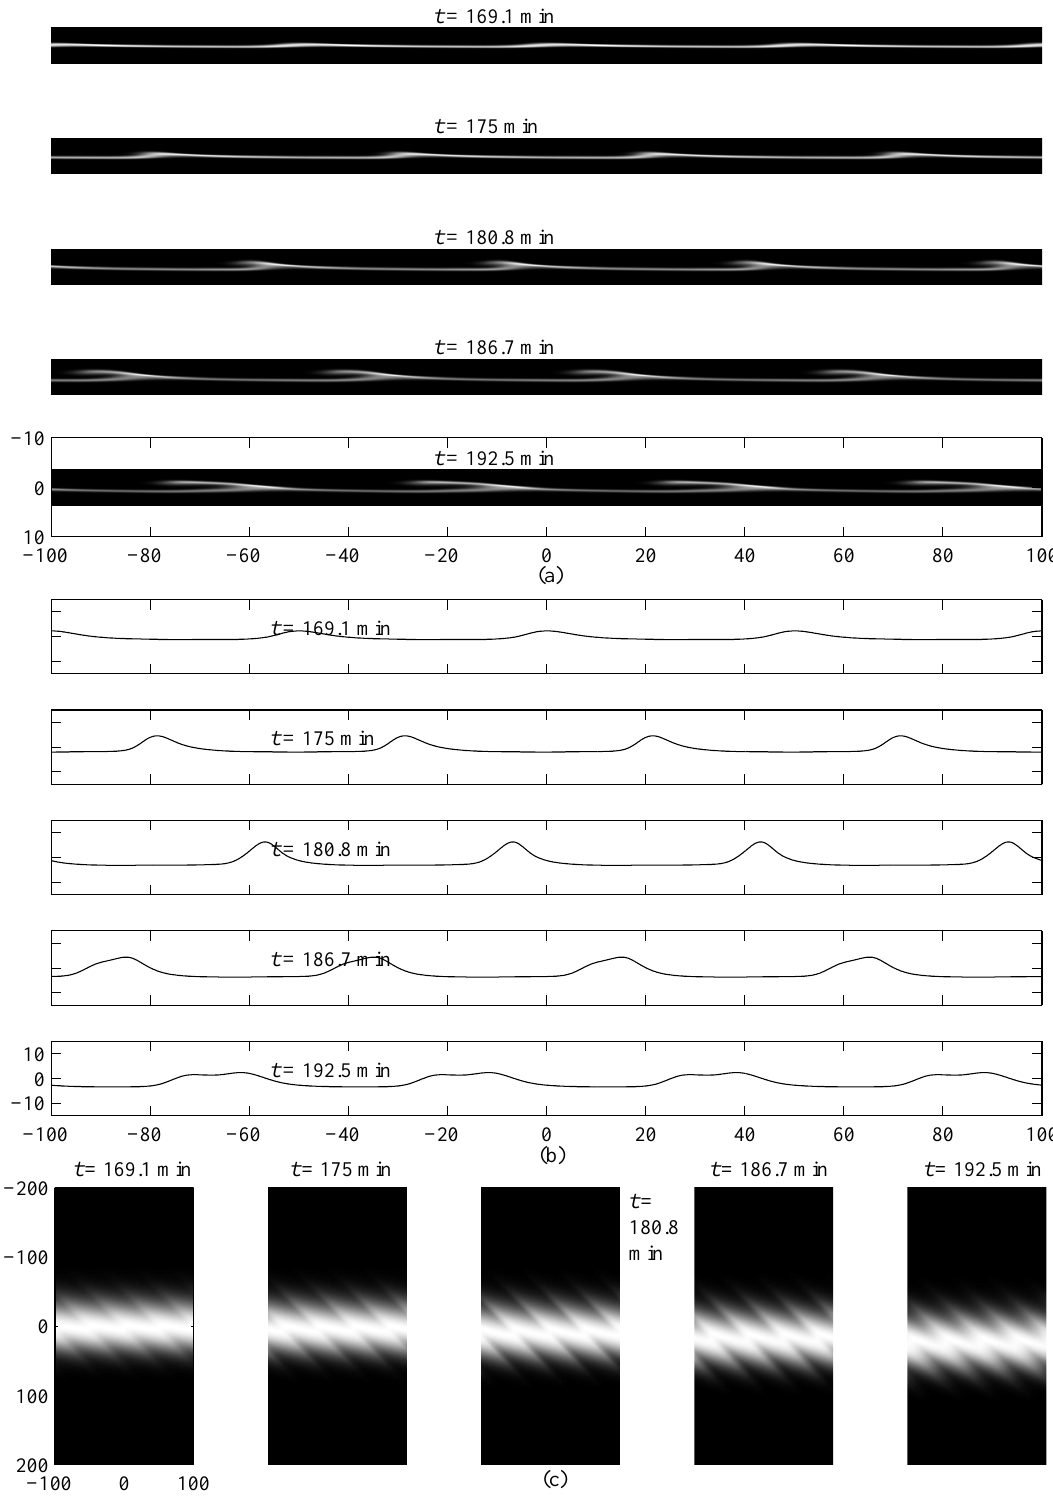
Figure 4: Seed wavelength of 50 km with Σ H Σ = 1 . 8. (a) E s layer, (b) electric field, and (c) F layer. The axes for all figures are described in Section 2.2, and summarized in Figure 1.